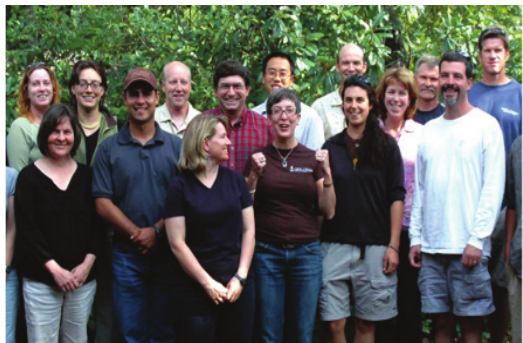
Figure 5. Dan Scollon, Shasta Community College, CA (in back row, third from right) commented, “Participation in iGETT has produced a multitude of benefits for me professionally and for my GIS program… The tangible outcomes and products from iGETT, including teaching resources, presentation materials, software and, most of all, the participant [exercises], have provided an essential starting point from which to begin offering remote sensing… at Shasta